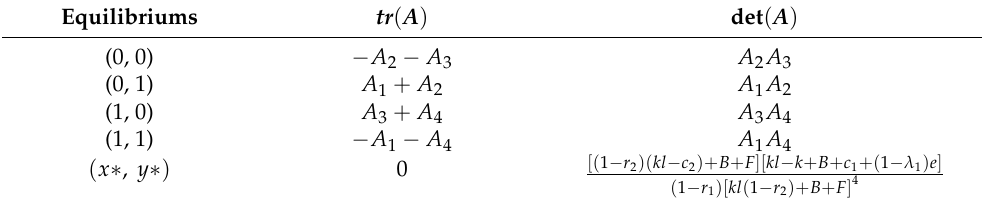
Table 2. Expression of the determinant and trace related to the four equilibrium points in system (11).